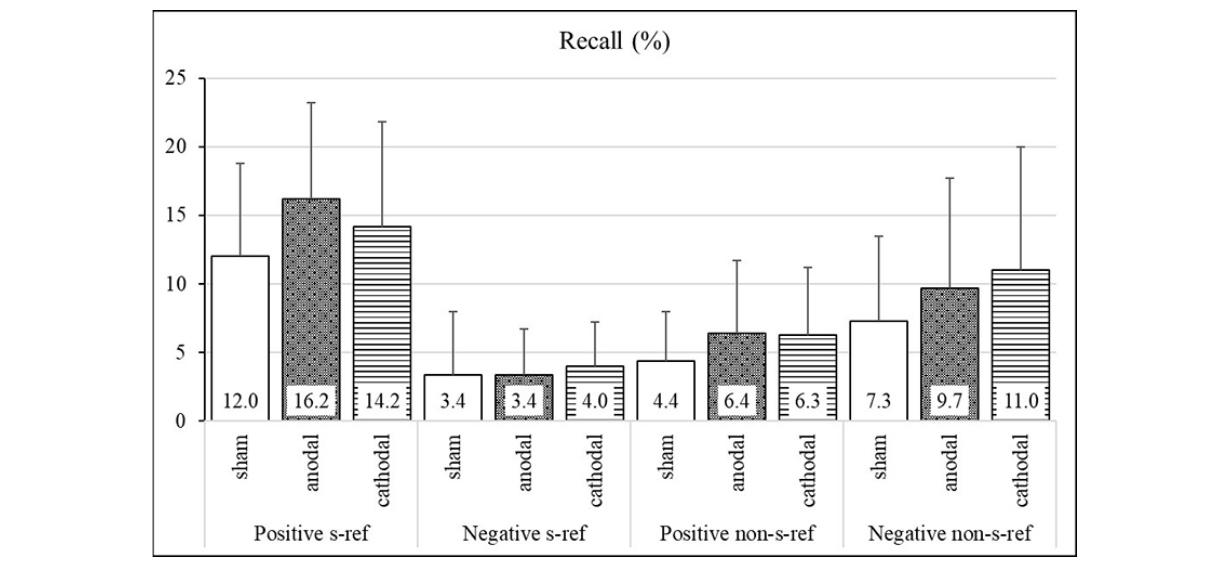
favor of a rather general than valence-specific recall advantage through